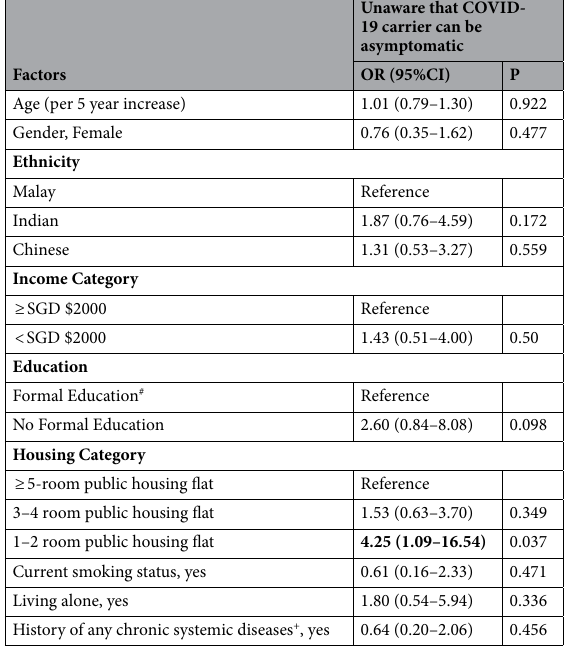
Table 4. Associations between demographic, socio-economic factors and medical history with knowledge level on COVID-19 transmission. SGD = Singapore Dollar. # Defined as having primary or higher education. + Defined as having diabetes, hypertension, chronic kidney disease, cardiovascular disease or hyperlipidaemia.